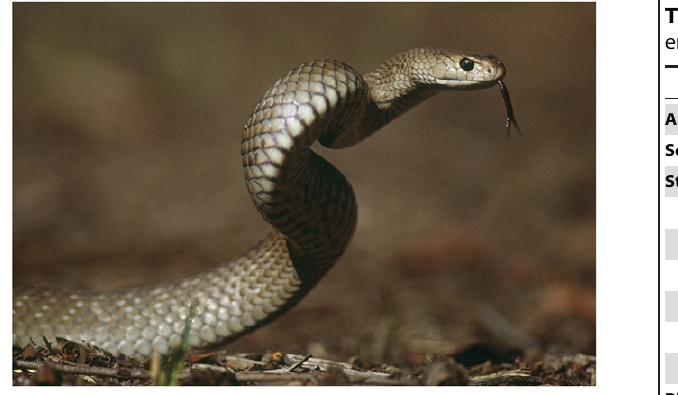
Figure 1. Brown snake (Pseudonaja textilis). Photo taken by Gunther Schmida.